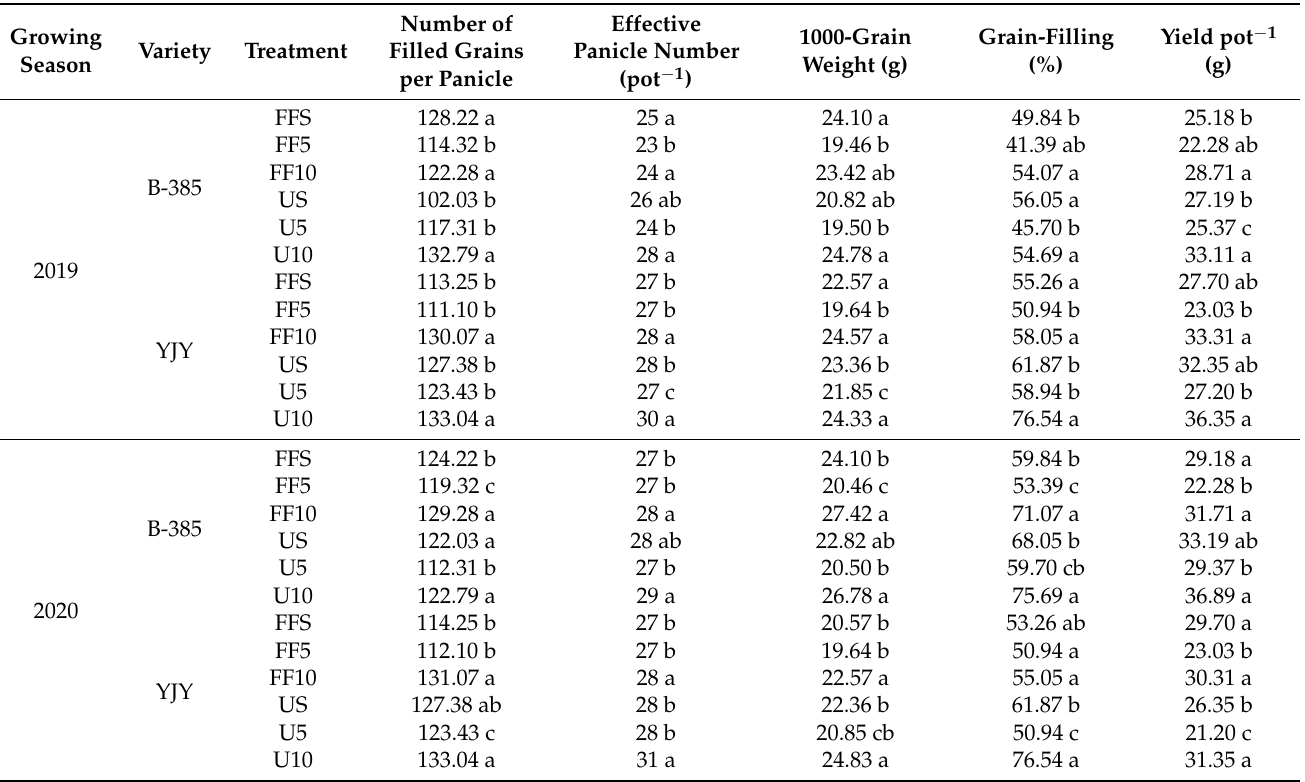
Table 2. Effects of different fertilizer placements on the yield of fragrant rice and its